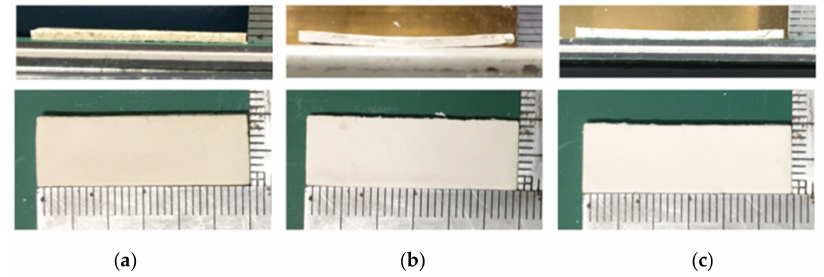
Figure 9. Configuration of the samples before and after drying (hot air temperature 100 ◦ C): ( a ) initial sample before drying; ( b ) after 1200 s in one side drying; and ( c ) after 600 s in both sides drying.